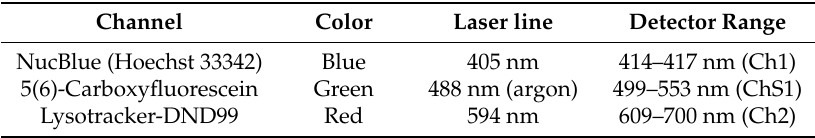
Table 1. Laser and detector ranges used during live cell